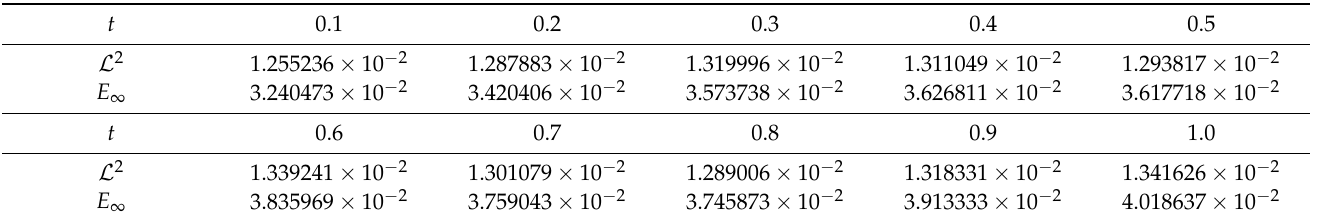
Table 4. Problem of Example 3: Relative spatial error L 2 and maximum absolute error E ∞ at some time nodes, where ∆ t is fixed to be